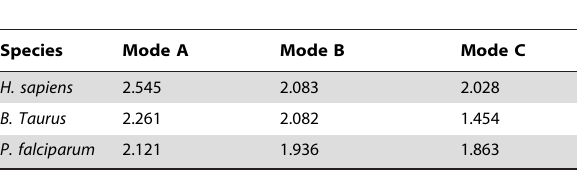
Table 1. Degree of coupling of the slow conformational modes to the cis/trans isomerization catalyzed by CypA.